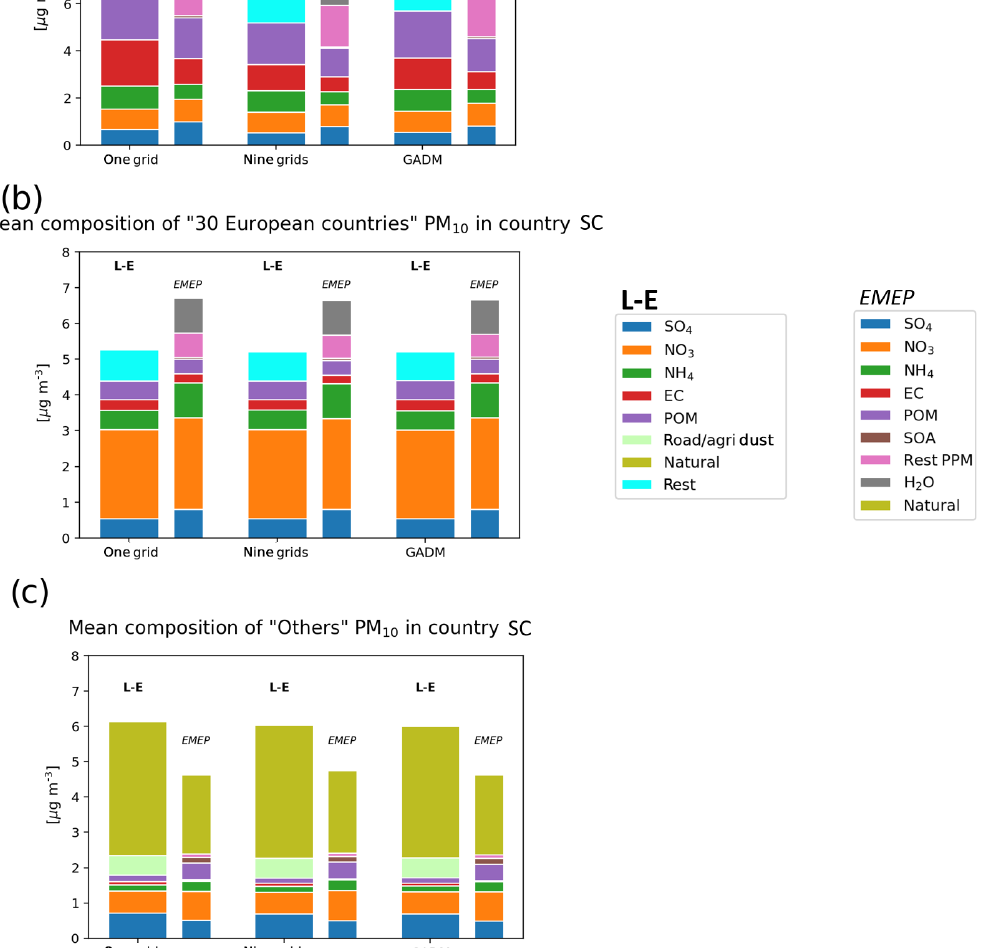
Figure 8. Mean composition of (a) Domestic, 30 (b) European countries, and (c) Others PM 10 calculated by the LOTOS-EUROS (L-E) country SC over the 34 European cities and for each 4d forecast. The result from the EMEP country SC, by using a 15% perturbation run, has also been added for comparison. The PM 10 composition is highlighted with the colour code. Rest corresponds to the difference between the PM 10 and the sum of the components listed on the plot. The results for the three city definitions (one grid, nine grids, and GADM) are shown. The Domestic contribution corresponds to the contribution from the domestic country to the city (e.g. from France to Paris). The label 30 European countries corresponds to the other 30 European countries used in the study. Others in the LOTOS-EUROS country SC is slightly different from the EMEP Others. Others in the LOTOS-EUROS country SC contains natural sources, other countries included in the regional domain, boundary conditions, dust emitted by road traffic and agriculture, ship traffic, the aircraft emissions, and